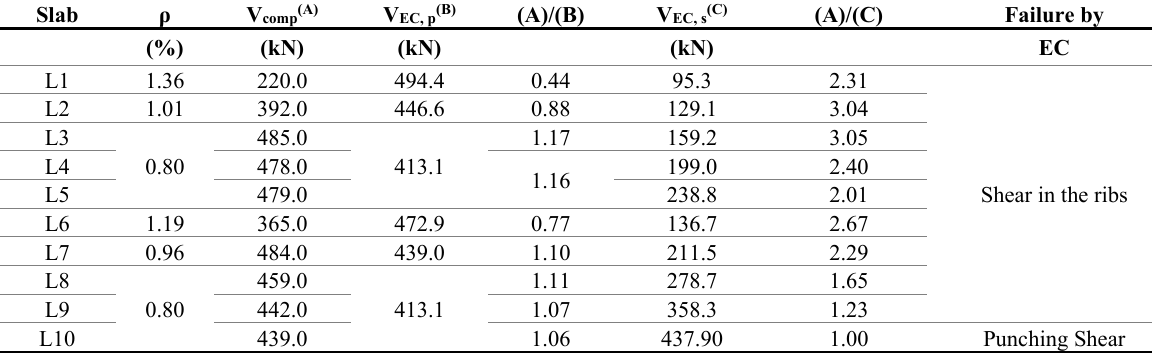
Table 5. Computational and Eurocode 2 [6] results